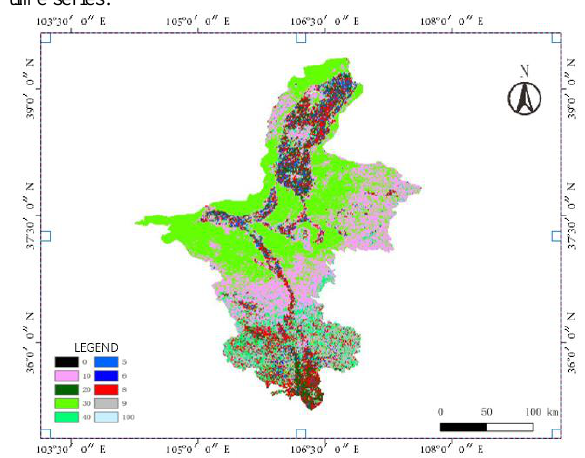
Figure 8 . k-means clustering results for a one-year period time